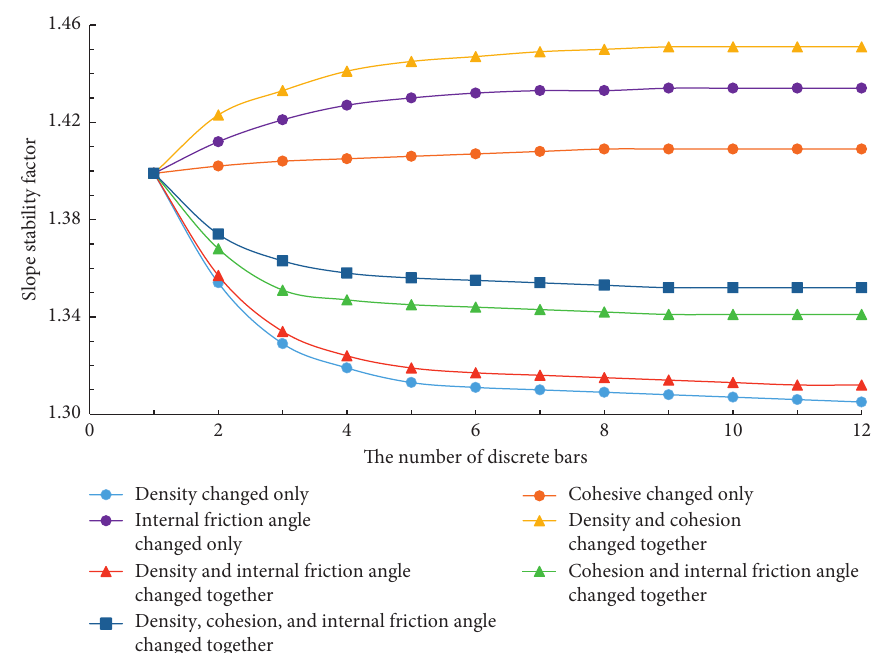
Figure 5: Variation law of the slope stability